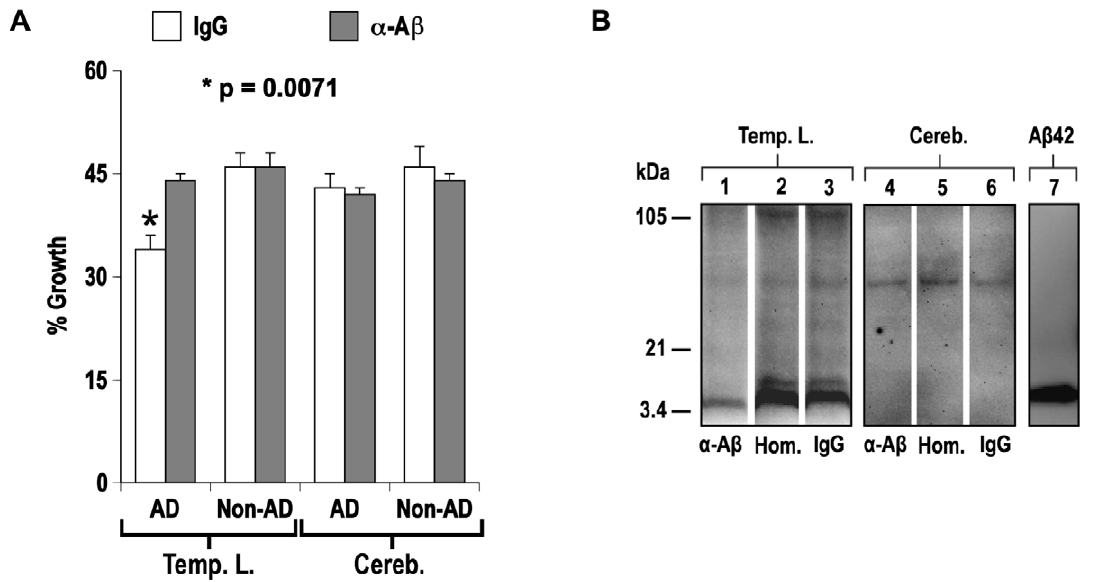
Figure 4. Immunodepletion of A b from AD brain homogenates attenuates C.albicans inhibition. Homogenates of temporal lobe ( Temp. L. ) and cerebellum ( Cereb. ) were prepared from AD (n=32) or non-demented (n=13) subjects. AD ( AD ) or non-demented ( non-AD ) homogenates were pooled and then incubated with Magno-beads pre-loaded with rabbit IgG ( IgG ) or a polyconal rabbit anti-A b antibody ( a -A b ). Following bead removal samples were analyzed for A b signal by Western blot and assayed for C. albicans growth by alamar blue viability assay. Panel A shows C. albicans growth in treated homogenates as a percentage of signal in culture broth alone. Immunodepletion of AD temporal lobe homogenates with a -A b restored microbial growth to levels equivalent to non-demented control samples. Graph shows average of five replicates 6 s.e.m. Panel B ; Untreated and immunodepleted homogenates (1:16 dilution) were Western blotted and probed with the A b -specific mAb 4G8 antibody. Analysis confirmed A b signal was reduced in temporal lobe homogenate incubated with anti-amyloid b -peptide antibody ( Lane 1 ) compared to sample incubate alone ( Lane 2 ) or with rabbit IgG ( Lane 3 ). A b in dilutions of cerebellum homogenate is below the level of detection for our experimental conditions ( Lanes 4–6 ). Blots included synthetic A b 42 ( A b 42 ) standard ( Lane 7 ). Statistical probability analysis ( p ) of data used unpaired two-tailed t-test.